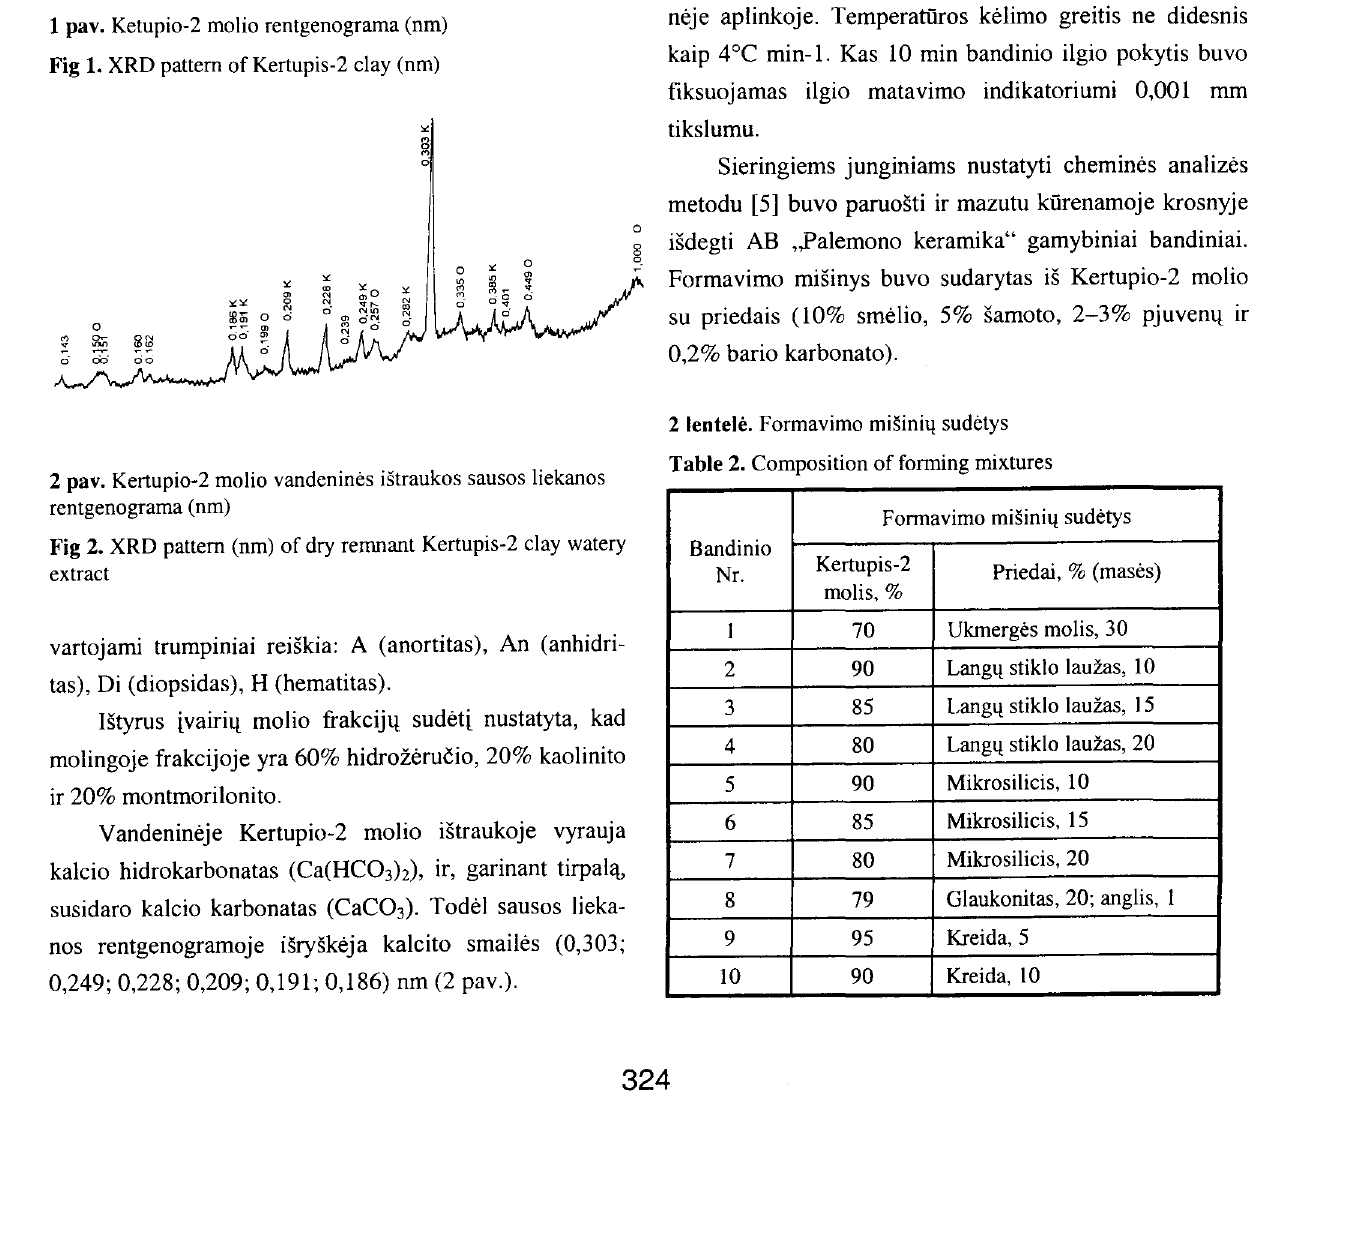
Fig 1. XRD pattern of Kertupis-2 clay (nm)